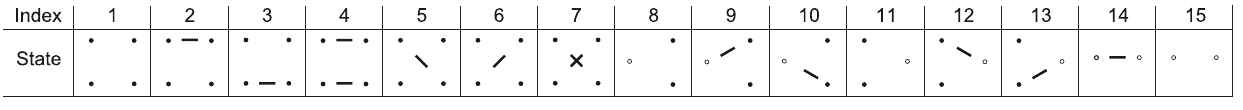
Figure 4. States for the two species system. For the two species system, we have one or two left and one or two right nucleotides. One when the left or right nucleotides have found their MRCA (open circles) and two otherwise (filled circles). Left nucleotides can be linked with right nucleotides or not.